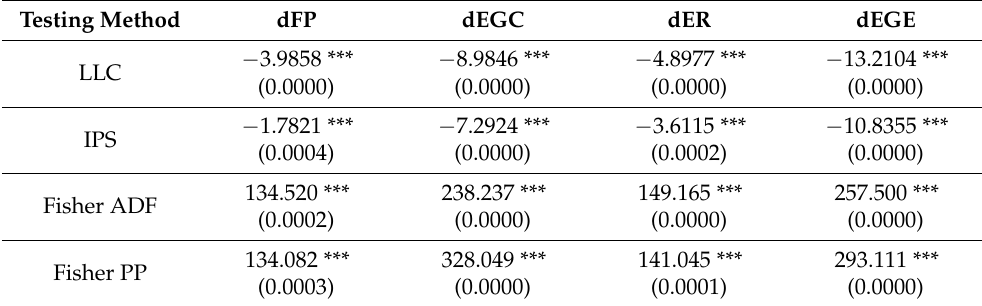
Table 4. Results of the panel unit root test.